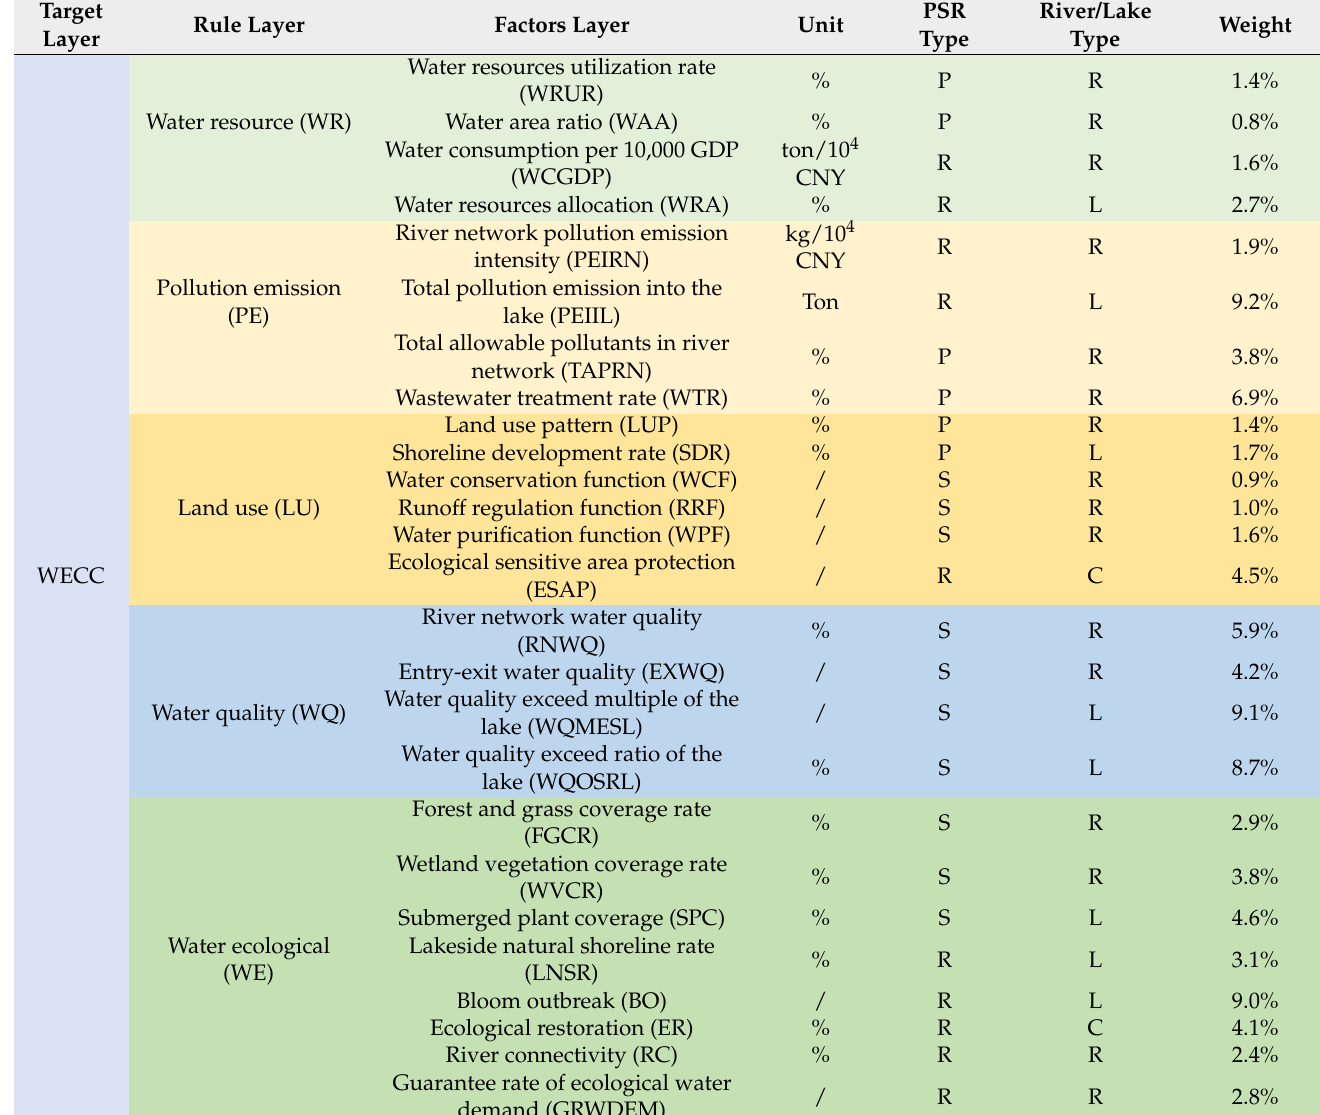
Table 3. Water Environmental Carrying Capacity (WECC) indicator